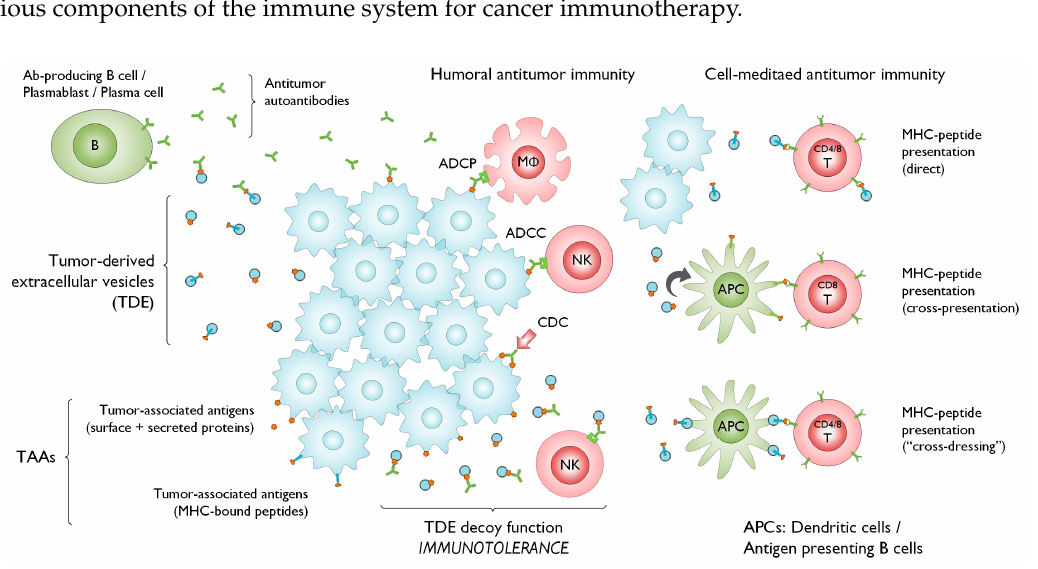
Figure 1. Tumor-derived extracellular vesicles (TDEs) dynamically mediate tumor B cell immune interaction. B cells are known to play roles in humoral as well as cell-mediated antitumor immunity. TDEs convey antigenic proteins and tumor-processed antigenic-peptide-loaded MHCs that complex with circulating plasma anticancer autoantibodies produced by various B cell subpopulations. TDEs function as competitive inhibitor decoys that bind antitumor antibodies and attenuate antibody-dependent cytotoxic and phagocytic immune functions. TDEs can activate CD4 + and CD8 + T cells by presenting MHC-bound antigenic peptides via direct and indirect presentation. B cells can function in the tumor microenvironment as antigen-presenting cells that process TDE antigenic protein cargos for cross-presentation to CD8 + T cells. TDEs expressing MHCs loaded with tumor-peptides can be surface presented directly by B cell without further processing (“cross-dressing”). These mechanisms have utility for developing tumor antigen targets, antitumor vaccines, and suggest strategies for mitigating EV-mediated immune escape to support next-generation cancer immunotherapies. ADCC, antibody-dependent cytotoxicity; ADCP, antibody-dependent cellular phagocytosis; APC, antigen-presenting cell; CDC, complement-dependent cytotoxicity; M Φ , macrophage; NK, natural killer cell.